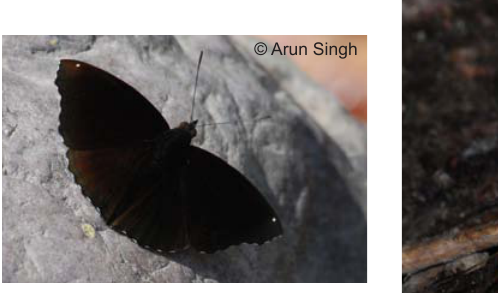
Image 51. Orange Awlet Burala jaina